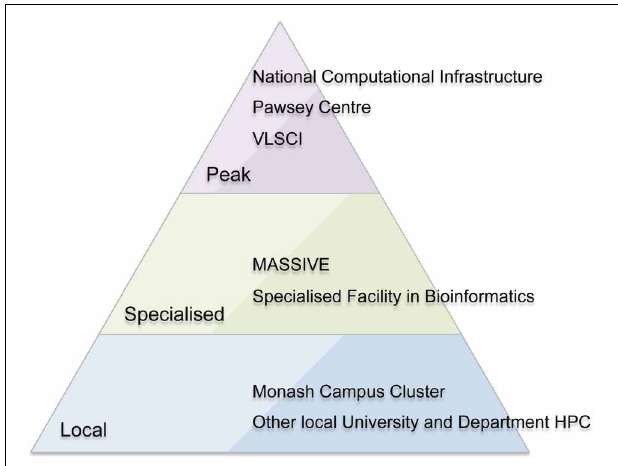
FIGURE 1 | The Australian high performance computing (HPC) environment including peak (national) facilities, specialized national facilities, and local HPC